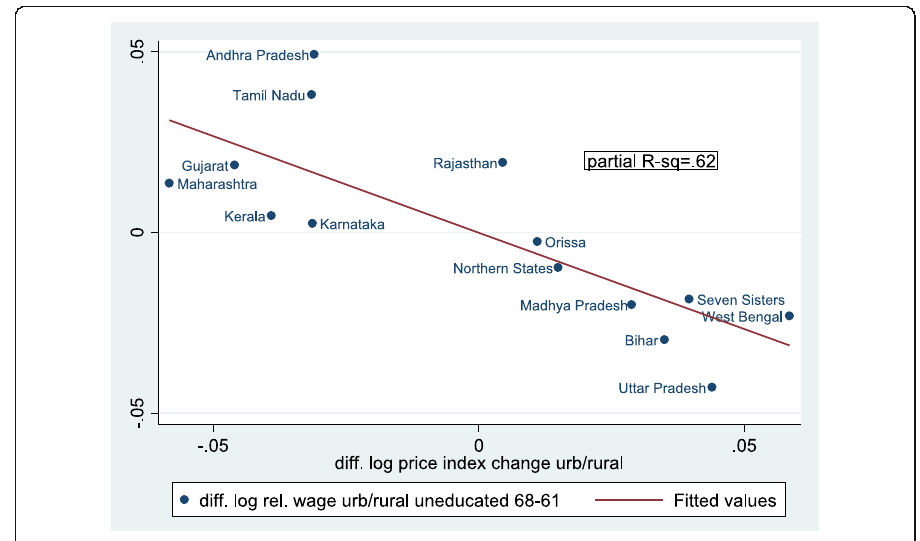
Fig. 17 Urban vs. rural wage changes and agricultural